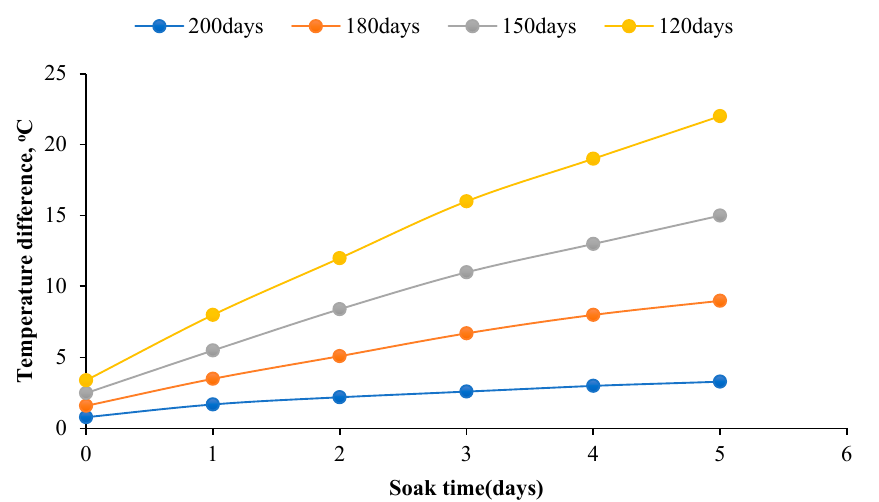
Figure 12. Temperature difference in horizontal length with soak time at different preheat timing.